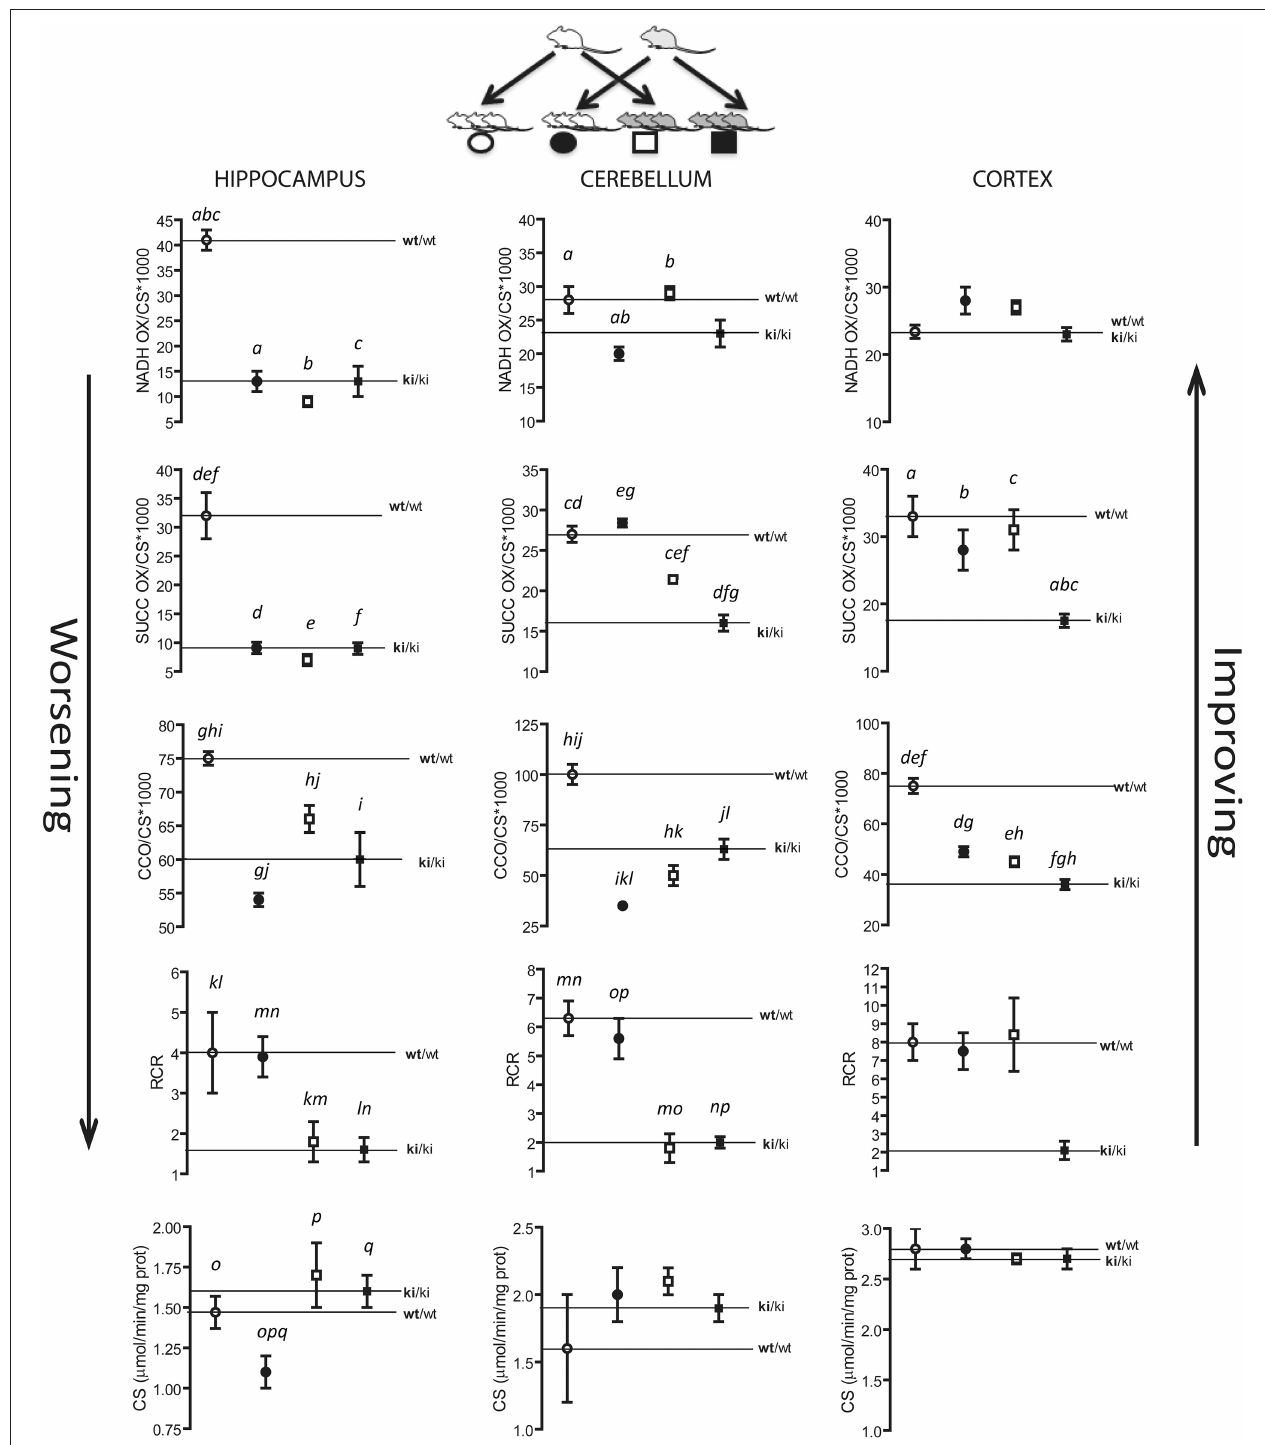
FIGURE 10 | Changes in mitochondrial outcomes in hippocampus, cerebellum and cortex of suckling WT and KI pups nursed on WT or KI dams. At birth, KI pups ( n = 24) and WT pups ( n = 24) were foster-nursed either on KI dams or WT dams, six pups on each dam. After 21 days, mitochondria were isolated from cortex, cerebellum, and hippocampus and activities of NADH oxidase, succinate oxidase, cytochrome c oxidase, and citrate synthase and RCR were evaluated as described in the Methods section. wt/wt = WT pups nursing on WT milk; ki/ki = KI pups nursing on KI milk. Circles represent WT pups, squares represent KI pups. White symbols represent WT milk and black symbols represent KI milk. Upward or downward arrows represent improvement or worsening, respectively, upon nursing on WT milk or KI milk. Activities (NADH oxidase, succinate oxidase, cytochrome c oxidase) were expressed as nmol × (min × mg protein) − 1 , normalized by citrate